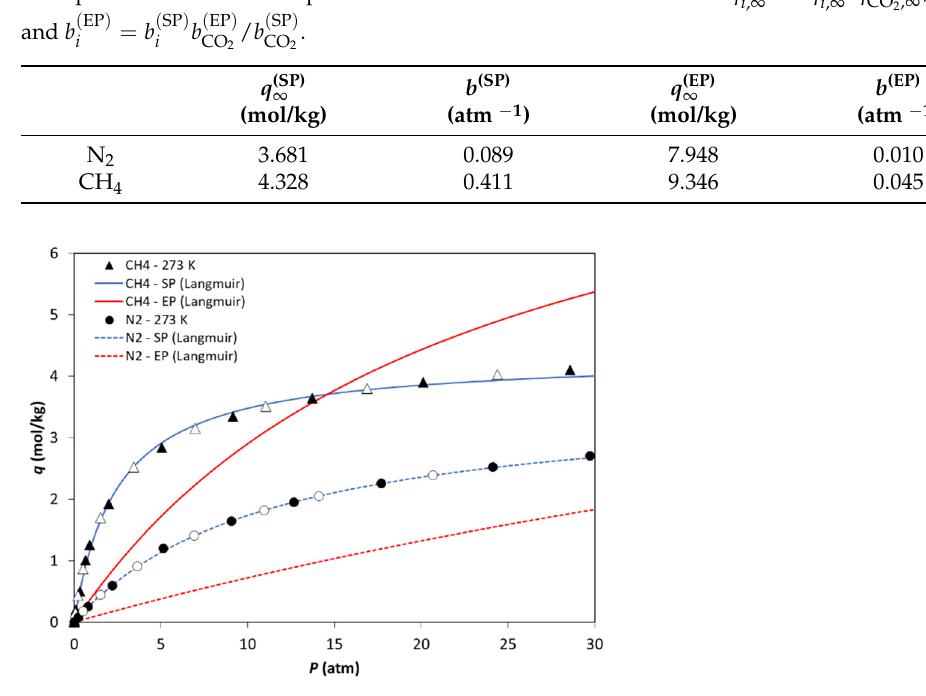
( EP ) ( EP ) ( SP ) = q ( SP ) q / q i , ∞ i , ∞ CO 2 , ∞ CO 2 , ∞